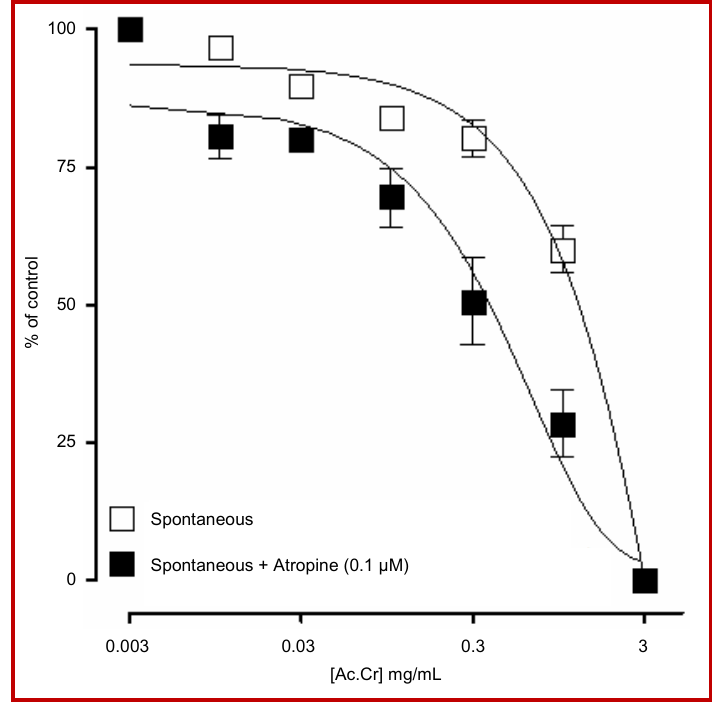
Figure 2: The concentration-dependent inhibitory effect of the crude extract of A. capillus-veneris (Ac.Cr) in the absence and pres- ence of atropine (0.1 µM) on spontaneous contractions in isolated rabbit jejunum preparations. Values are expressed as mean - ± S.E.M; n =